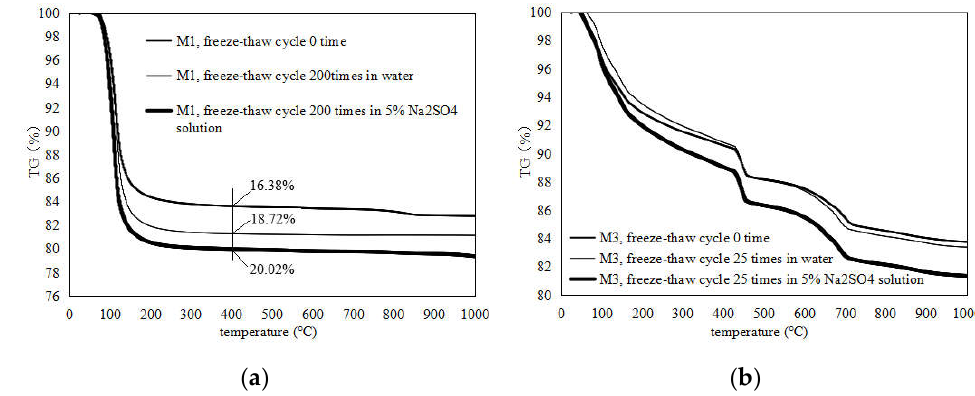
Figure 7. TG of M1 and M2 samples after different numbers of cycles of freeze–thaw in water and 5% Na 2 SO 4 . ( a ) M1; ( b )